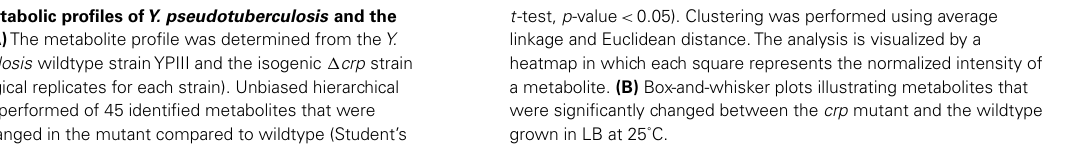
FIGURE 5 | Metabolic profiles of Y. pseudotuberculosis and the crp mutant. (A) The metabolite profile was determined from the Y. pseudotuberculosis wildtype strainYPIII and the isogenic ∆ crp strain YP89 (six biological replicates for each strain). Unbiased hierarchical clustering was performed of 45 identified metabolites that were significantly changed in the mutant compared to wildtype (Student’s